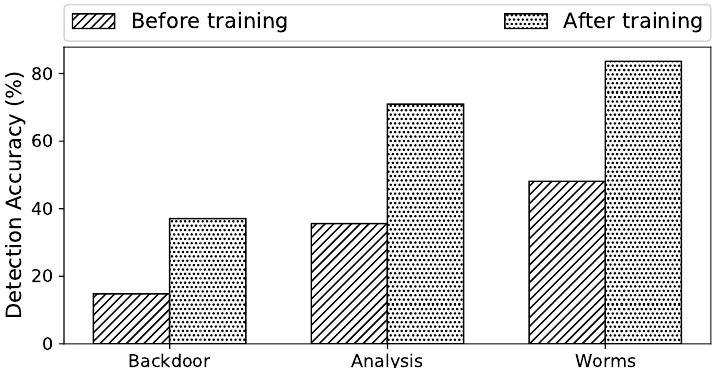
Figure 5. Comparing the attack detection accuracy of IMIDS before and after training with synthetic data generated by the proposed attack data